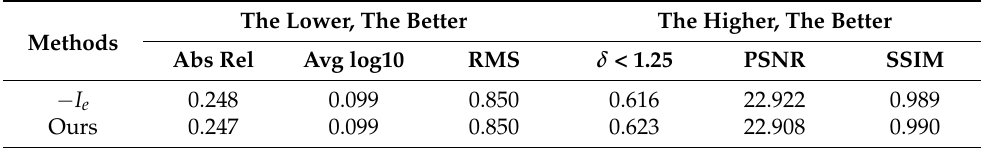
Table 4. Effectiveness of the edge auxiliary